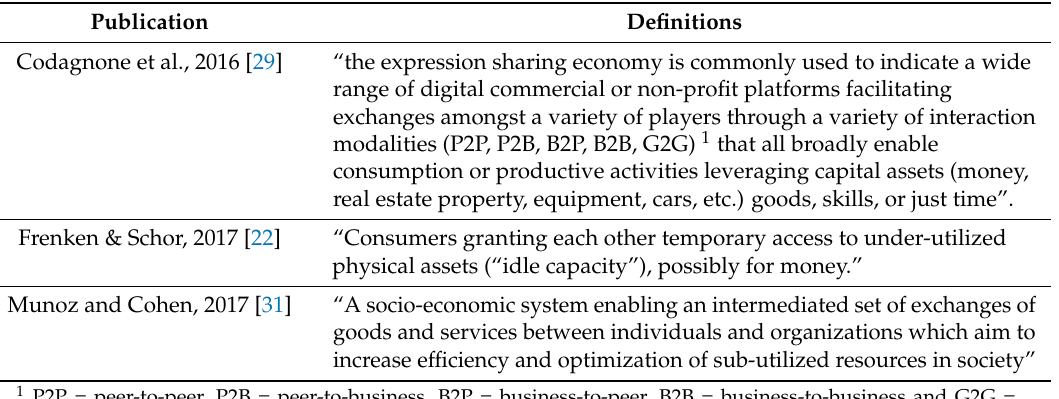
Table 1. Illustrative definitions of the sharing economy.